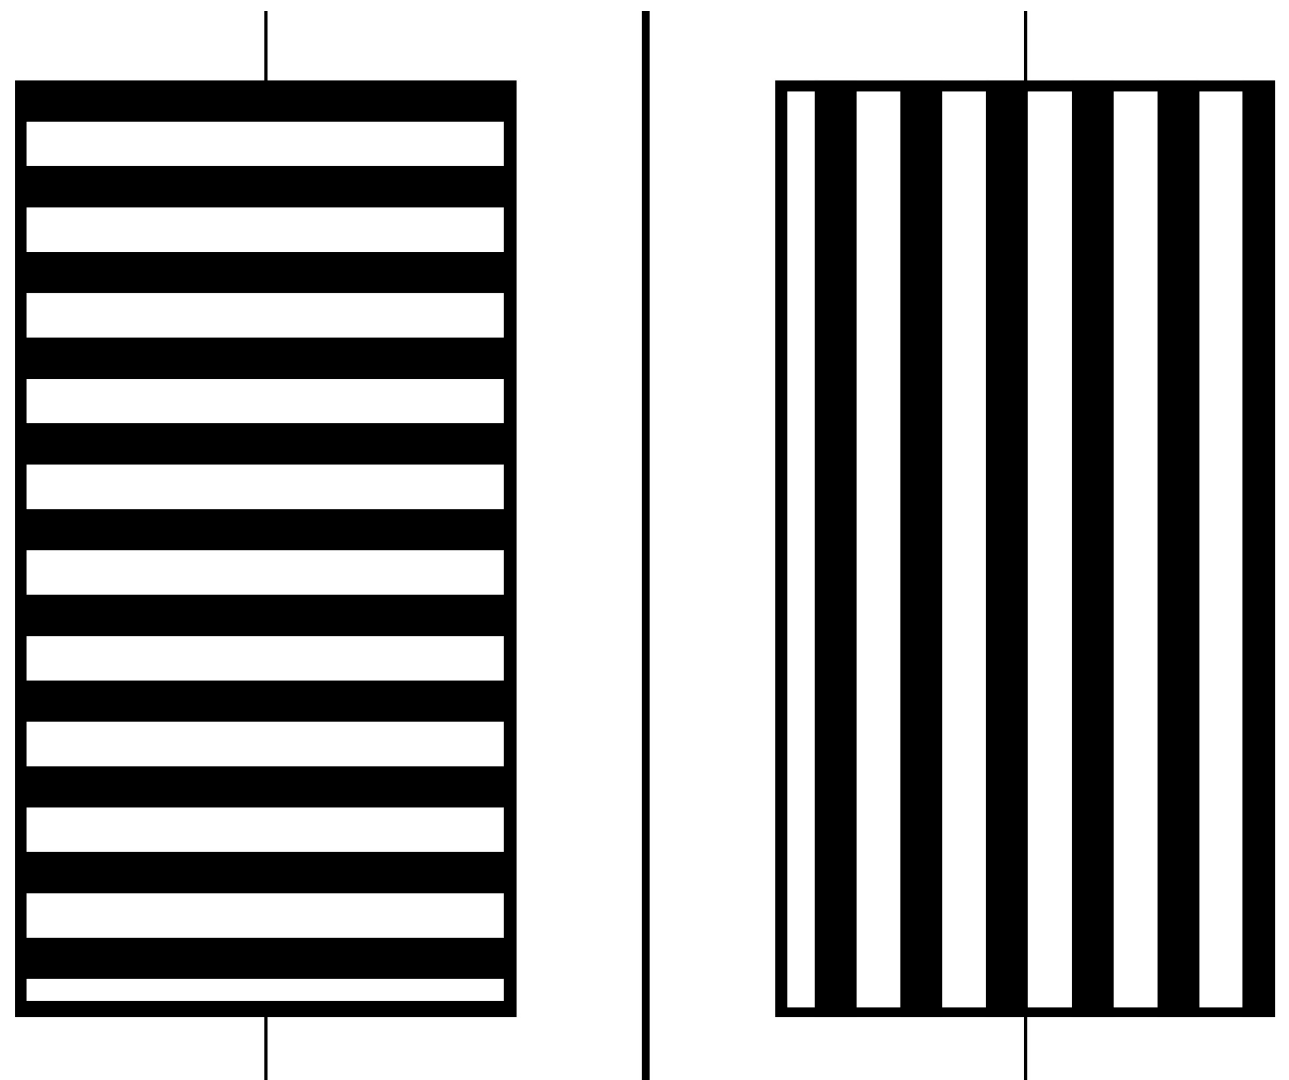
Fig 3. Binocular rivalry example. Stereogram of gratings image with a geometric disparity for demonstrating binocular rivalry, taken after Panum [15]; Panum’s gratings were at diagonals instead of horizontal and vertical). Either crossed or uncrossed fusion is appropriate. The entire fused image will rival.